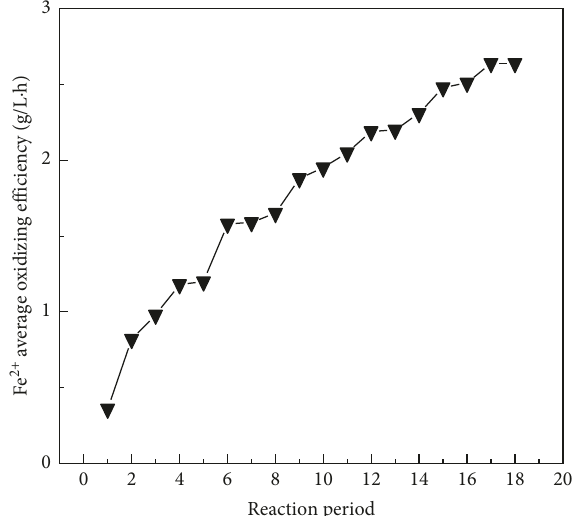
Figure 6: The trend of the average oxidation rate of Fe 2+ .